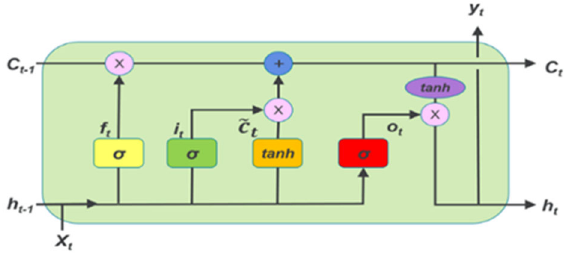
Figure 6. A repeating cell, which contains four interacting layers of an LSTM